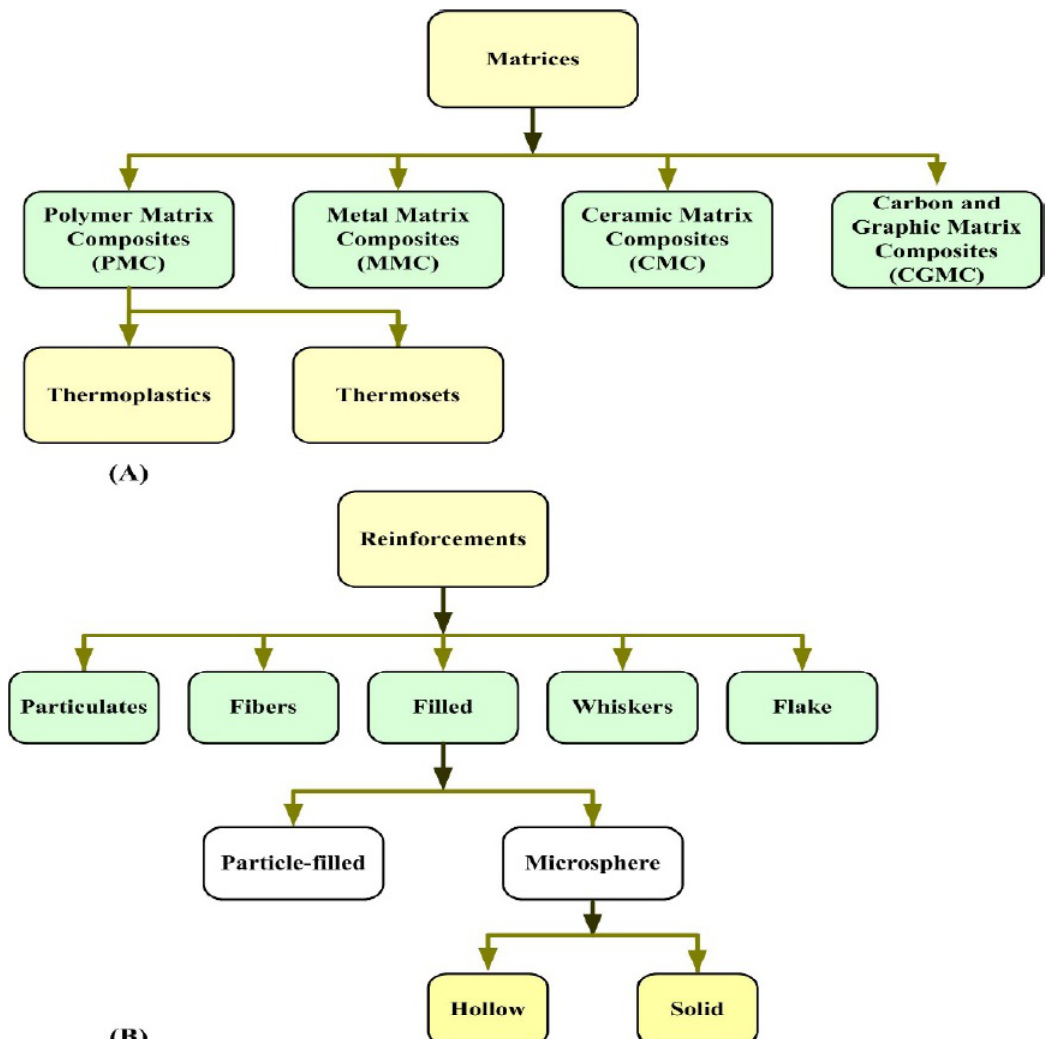
Fig. 7. A: Type 1 on the basis of matrix, B: Type.2 on the basis of reinforcements.